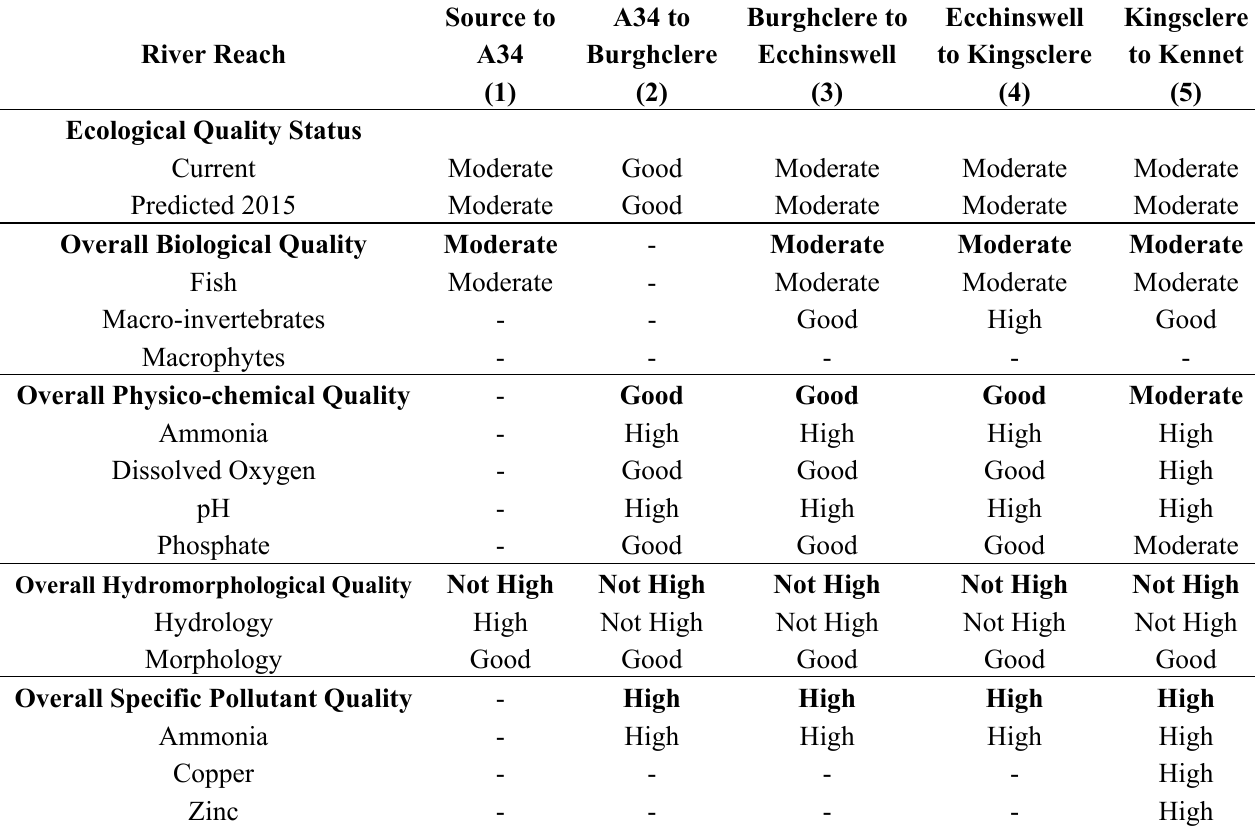
Table 4. Information on the current WFD status for the River Enborne and its